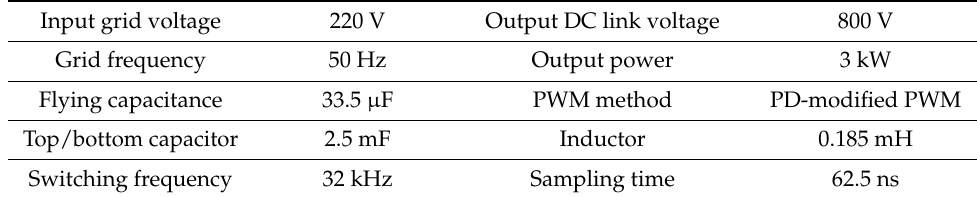
Table 5. Specifications and conditions of the simulation.